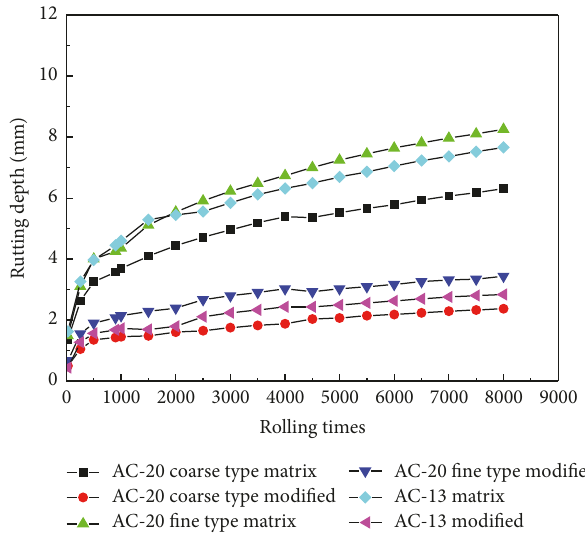
Figure 4: APA rutting depths of asphalt mixtures at 60 ∘ C under air- dry